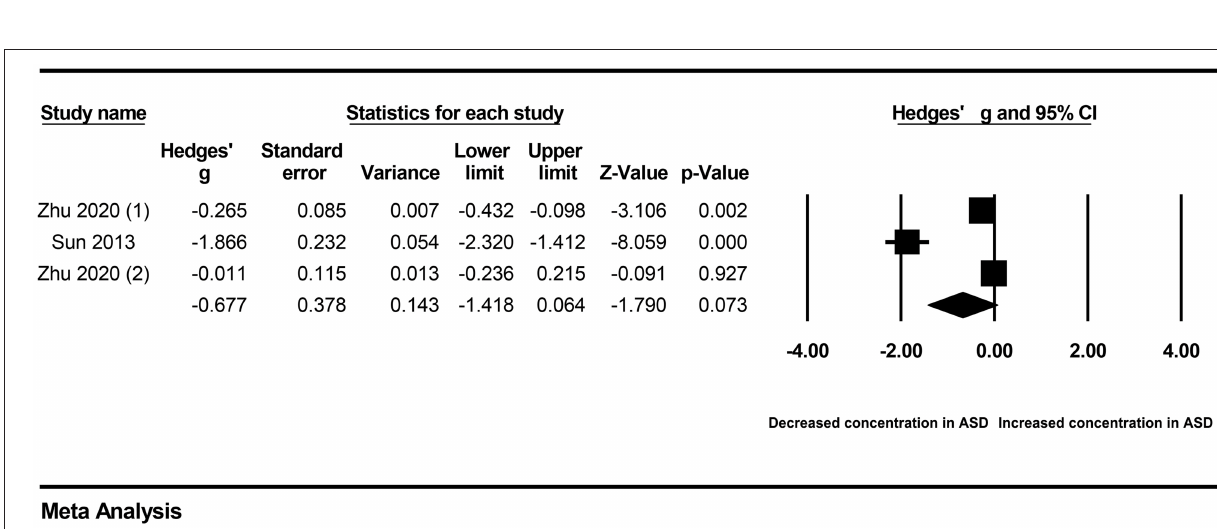
FIGURE 4 | Forest plot for the random-effects meta-analysis of the Chinese subgroup.